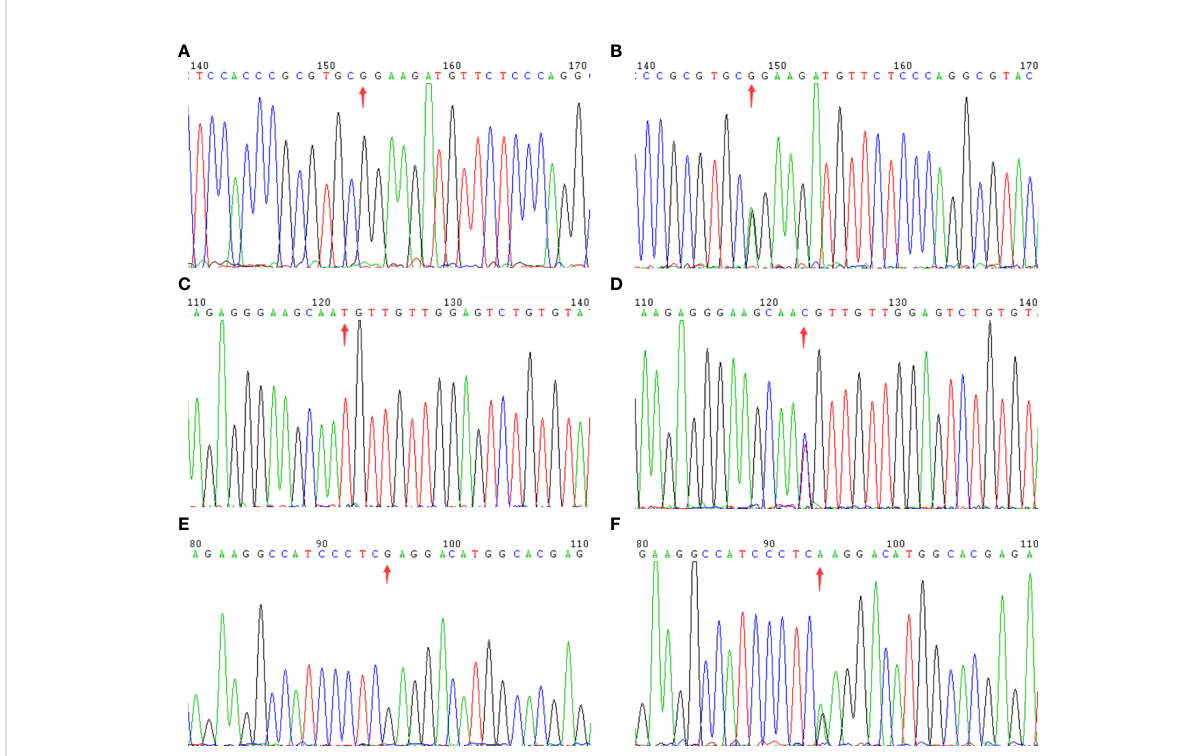
FIGURE 2 The sequencing chromatogram. Arrows indicate the changed position of the mutation in ABCC8 gene. Family A: (A) (wild type) and (B) (mutant type); Family B: (C) (wild type) and (D) (mutant type); Family C: (E) (wild type) and (F) (mutant